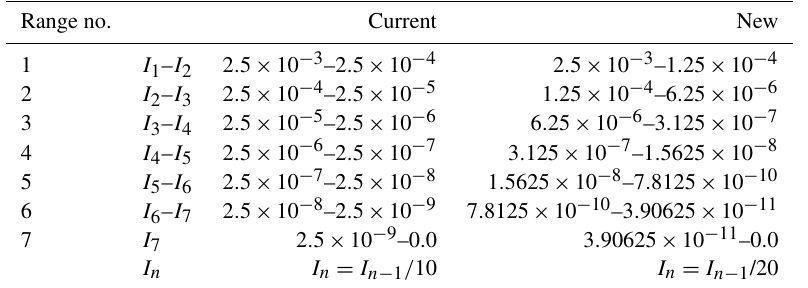
Table 2. Measurement range before (current) and after modification (new) of POM-02. I n and I n − 1 are the upper and lower limits of the current (unit: A), respectively. Range no.